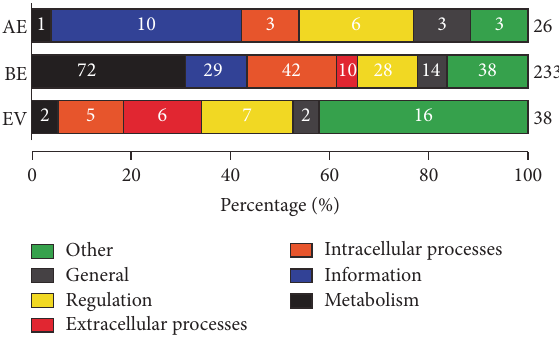
Figure 2: Functional composition of AE, BE, and EV Venn groups. FSFs were mapped to one of the seven major functional categories of molecular functions (i.e., Metabolism , Information , Regulation , Intracellular Processes , Extracellular Processes , General , and Other ), as defined by Christine Vogel (http://supfam.org/SUPERFAMILY/ function.html) [47–49]. Numbers on the right indicate total number of FSFs for which functional annotation was available. Numbers on bars indicate total number of FSFs annotated to each of the seven major functional categories in that